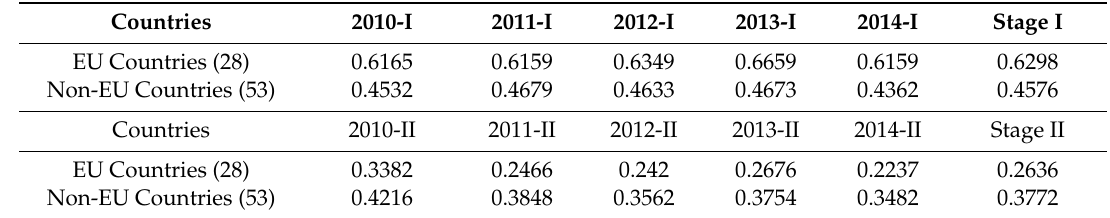
Table 7. Average overall e ffi ciency in EU and non-EU countries from 2010 to 2014 in each stage. Countries 2010-I 2011-I 2012-I 2013-I 2014-I Stage I EU Countries (28) 0.6165 0.6159 0.6349 0.6659 0.6159 0.6298 Non-EU Countries (53) 0.4532 0.4679 0.4633 0.4673 0.4362 0.4576 Countries 2010-II 2011-II 2012-II 2013-II 2014-II Stage II EU Countries (28) 0.3382 0.2466 0.242 0.2676 0.2237 0.2636 Non-EU Countries (53) 0.4216 0.3848 0.3562 0.3754 0.3482